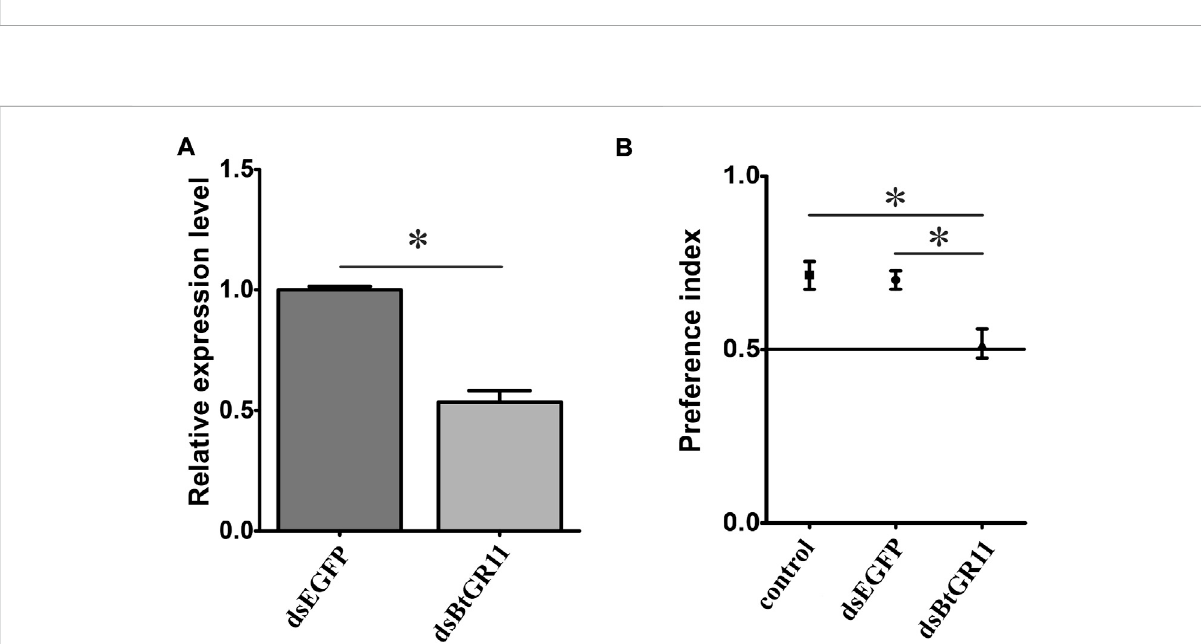
Frontiers in Bioengineering and